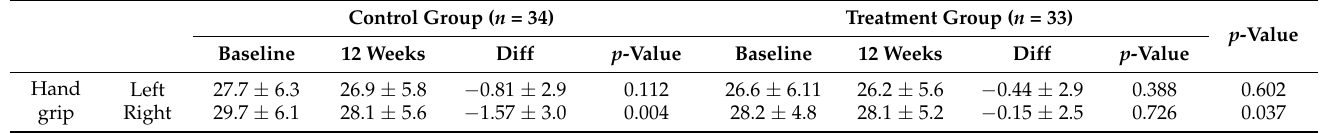
Table 3. Effects of tannase-treated green tea extract on grip strength. Control Group ( n = 34)